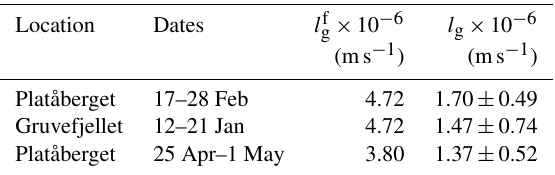
Table 3. Comparison results with field